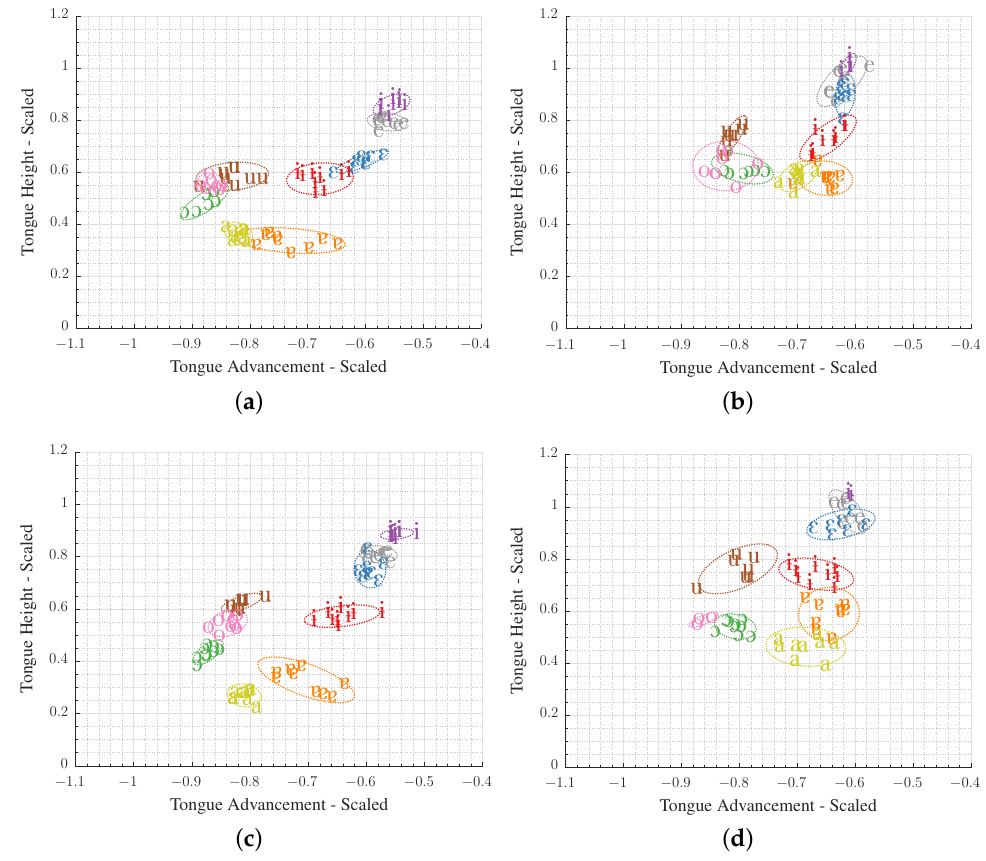
Figure 10. Vowel articulatory cluster size of all EP vowels of two speakers in pVCv sequences (top) ( a , b ) and in isolated context (bottom) ( c , d ). Left side: young female (Y2); Right side: old female